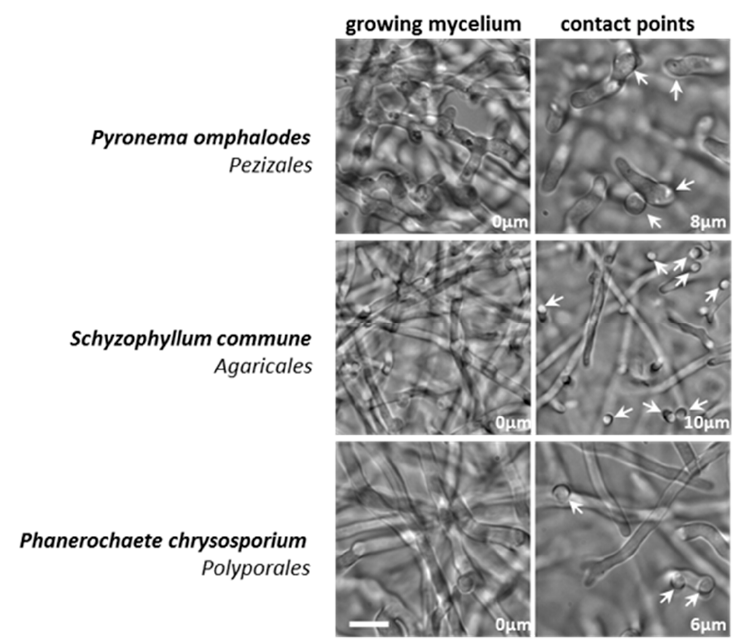
Figure 5. Reorientation and contact points without cellophane penetration. The Pezizomycetes Pyronema omphalodes , as well as the Agaricomycetes Schizophyllum commune and Phanerochaete chrysosporium exert clear tropism towards cellophane. Both columns represent different z-planes of the same field of view. The distances from the initial z-plane are indicated. Left column: mycelium growing on top of the cellophane layer. Right column: contact points (arrows) observed following hyphal growth reorientation. Scale bar = 10µm.